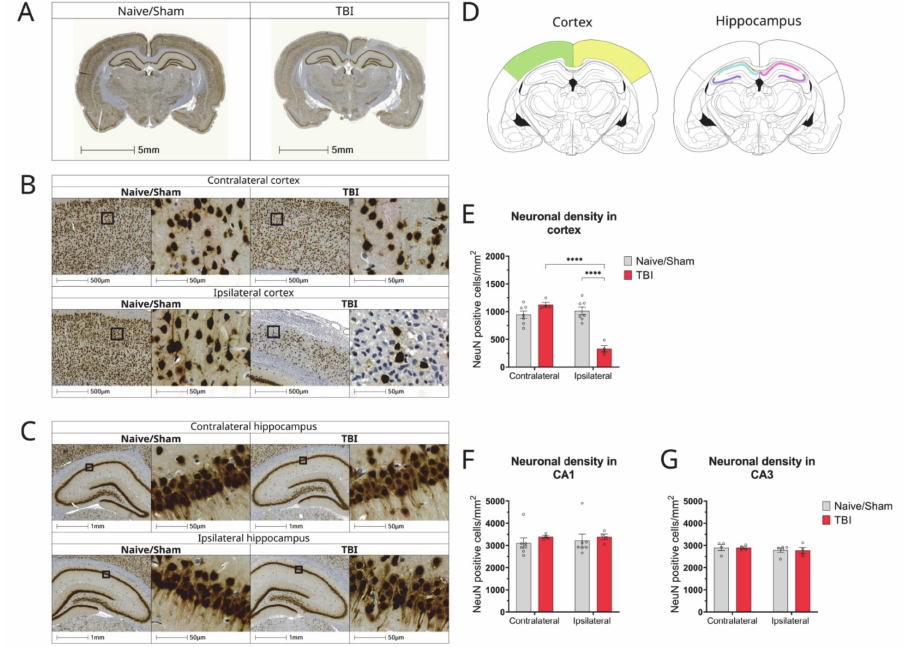
Figure 5. Changes in neuronal density and distribution in cortex and hippocampus of CCI rat brains 2 weeks post-injury. ( A ) Representative whole brain photomicrographs of NeuN+ staining in naïve/control and CCI rat brains; ( B ) Magnified representative images of NeuN staining in cortex of Naïve/sham animals and CCI brains from ipsilateral and contralateral sides of the injury; ( C ) Magnified representative images of NeuN staining in the hippocampus of Naïve/sham animals and CCI brains from ipsilateral and contralateral sides of the injury; ( D ) Brain atlas images, showing areas of cortex and hippocampus analysed; ( E ) Quantification of the NeuN+ cell count/mm 2 in the cortex of CCI and sham/naïve control rats (2-way ANOVA hemisphere F(1,18) = 27.57 p < 0.0001, injury F(1,18) = 13.19 p = 0.0019, interaction F(1,18) = 38.87 p < 0.0001); ( F ) Quantification of NeuN+ neurons in the CA1 area of the hippocampus of CCI and sham/naïve control rat (two-way ANOVA hemisphere F(1,18) = 0.05058 p = 0.8246, injury F(1,18) = 0.7830 p = 0.3879, interaction F(1,18) = 0.5585 p = 0.8159); ( G ) Quantification of number of neurons in the CA2 area of the hippocampus of CCI and sham/naïve control rats (2-way ANOVA hemisphere F(1,13) = 1.171 p = 0.2989, injury F(1,13) = 0.007 p = 0.9331, interaction F(1,13) = 0.003 p = 0.9520). All data are presented as mean ± SEM, n = 5–7 per group. Two-way ANOVA, **** p < 0.0001. Mouse brain atlas images were obtained from the Allen Institute website (www.alleninstitute.org, accessed on 29 September